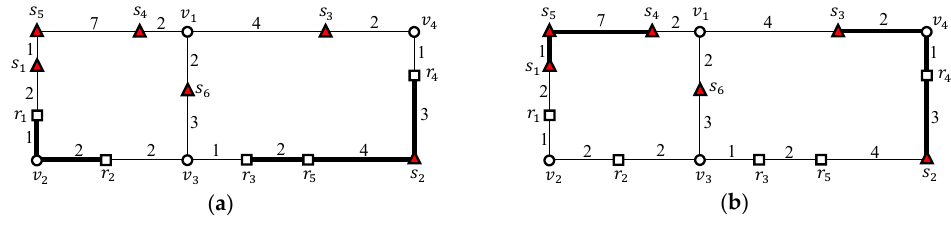
(cid:12) (cid:12) (cid:12) R (cid:12) = 2; ( b ) S = { s 1 s 5 s 4 , s 2 s 3 , s 6